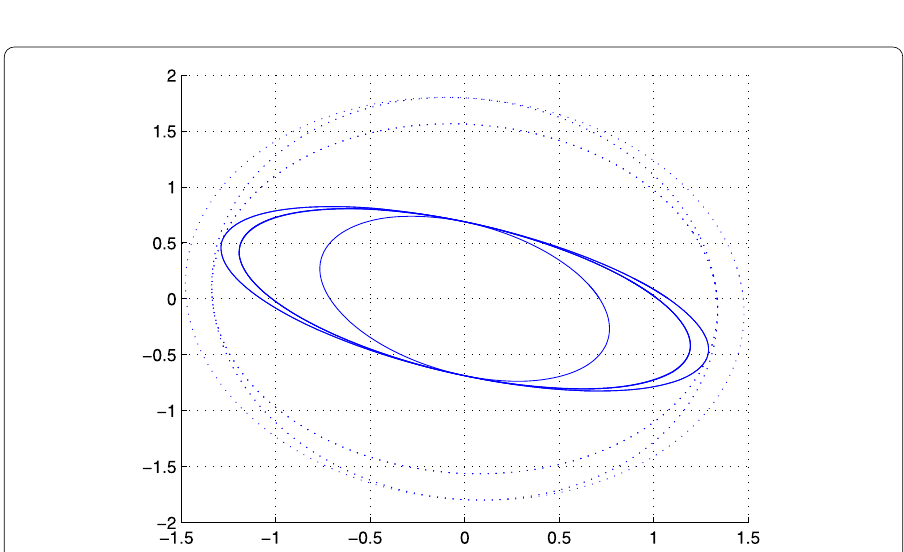
Figure 2 The reachable set estimation for the singular system (1) with φ ( t ) =